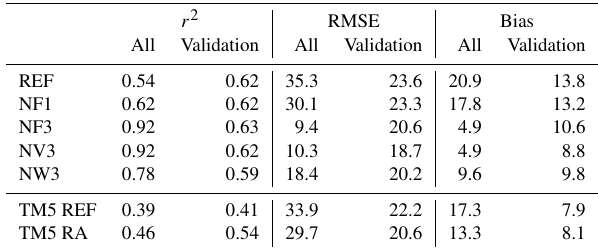
Table 5. Mean values of r 2 , RMSE and absolute bias for different FLEXPART CTM and TM5 simulations at surface stations for all stations or independent validation stations only. r 2 RMSE Bias All Validation